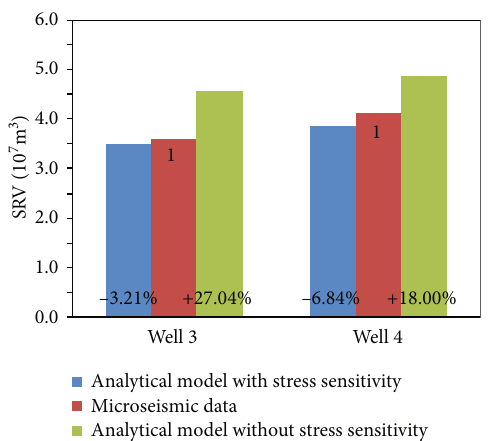
Figure 14: Comparison between the analytical model with or without considering stress sensitivity and the microseismic